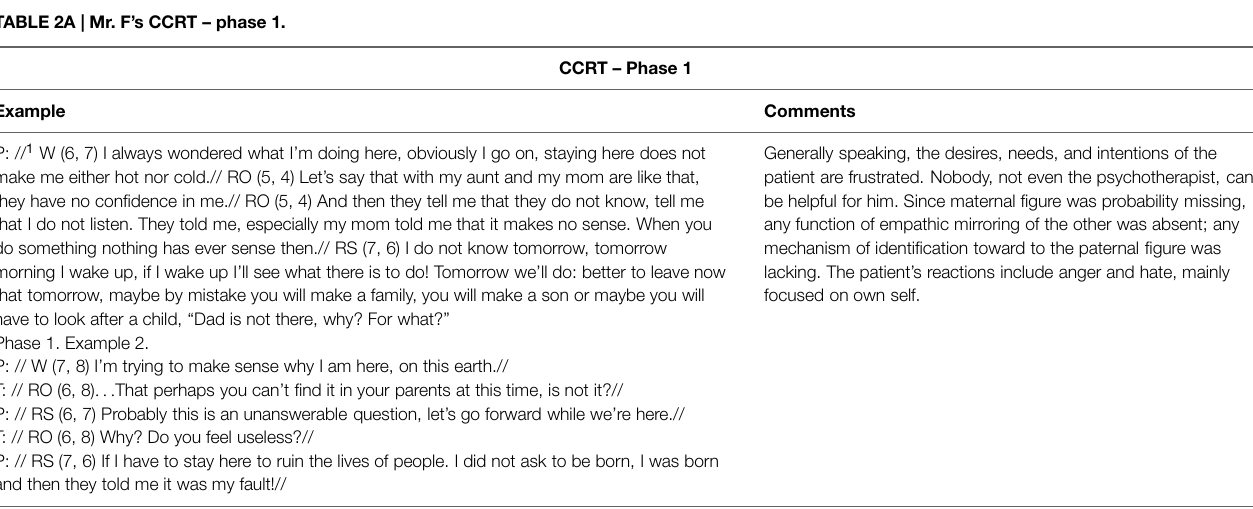
TABLE 2A | Mr. F’s CCRT – phase